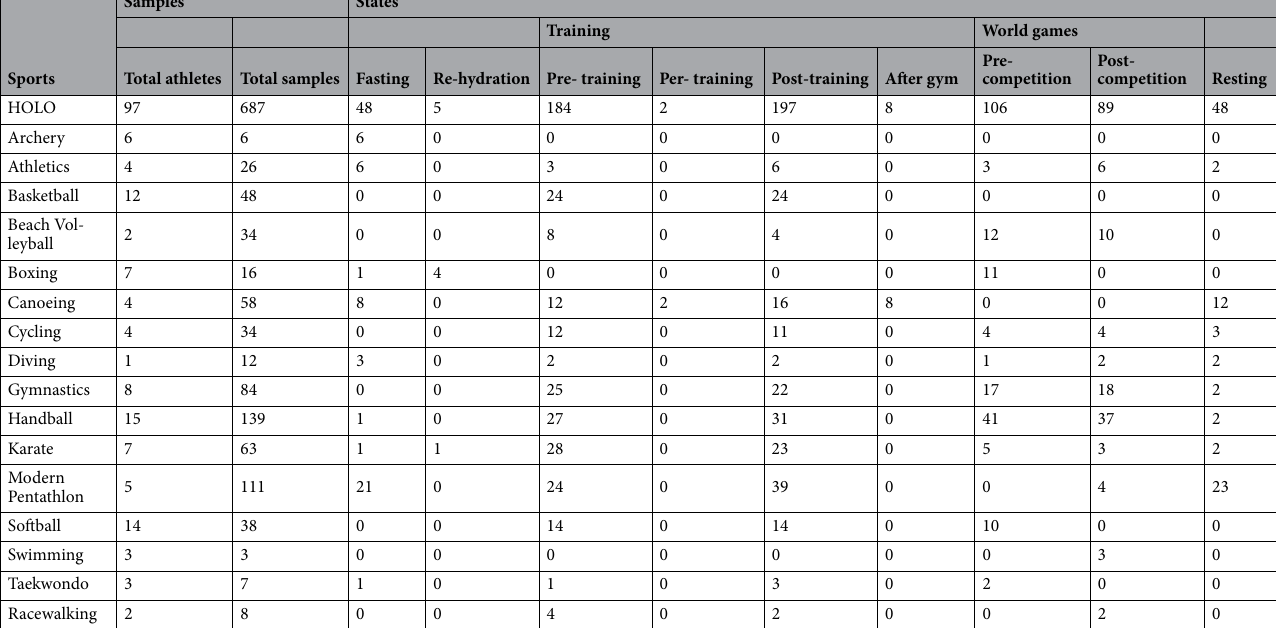
Table 1. Samples were collected in nine different states: fasting (eight hours minimum), re-hydration (rapid re-hydration after fasting and hydration deprivation), pre-, per-, or post-technical training; after physical training; pre- or post-competition and resting (60–90 min after either training or competition). HOLO refers to all combined, holistic samples and analysis.